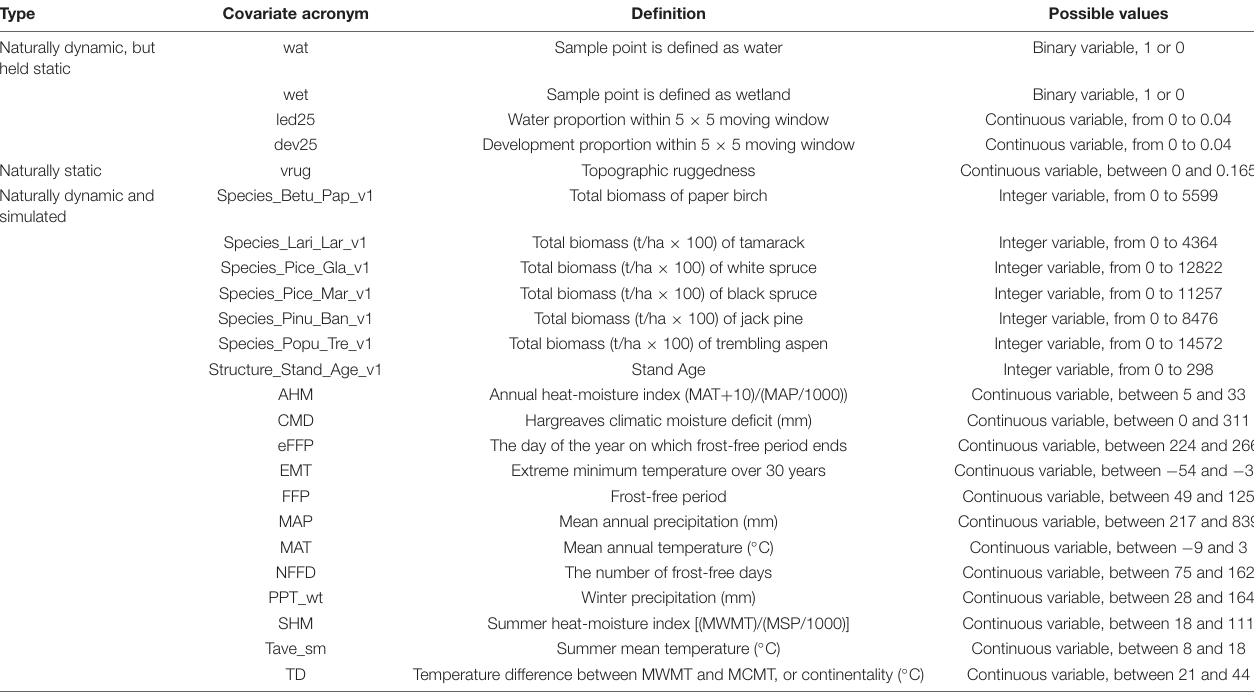
TABLE 3 | Type of covariates, covariate acronyms, definitions, and range of possible values for the covariates used to build the landbird models.